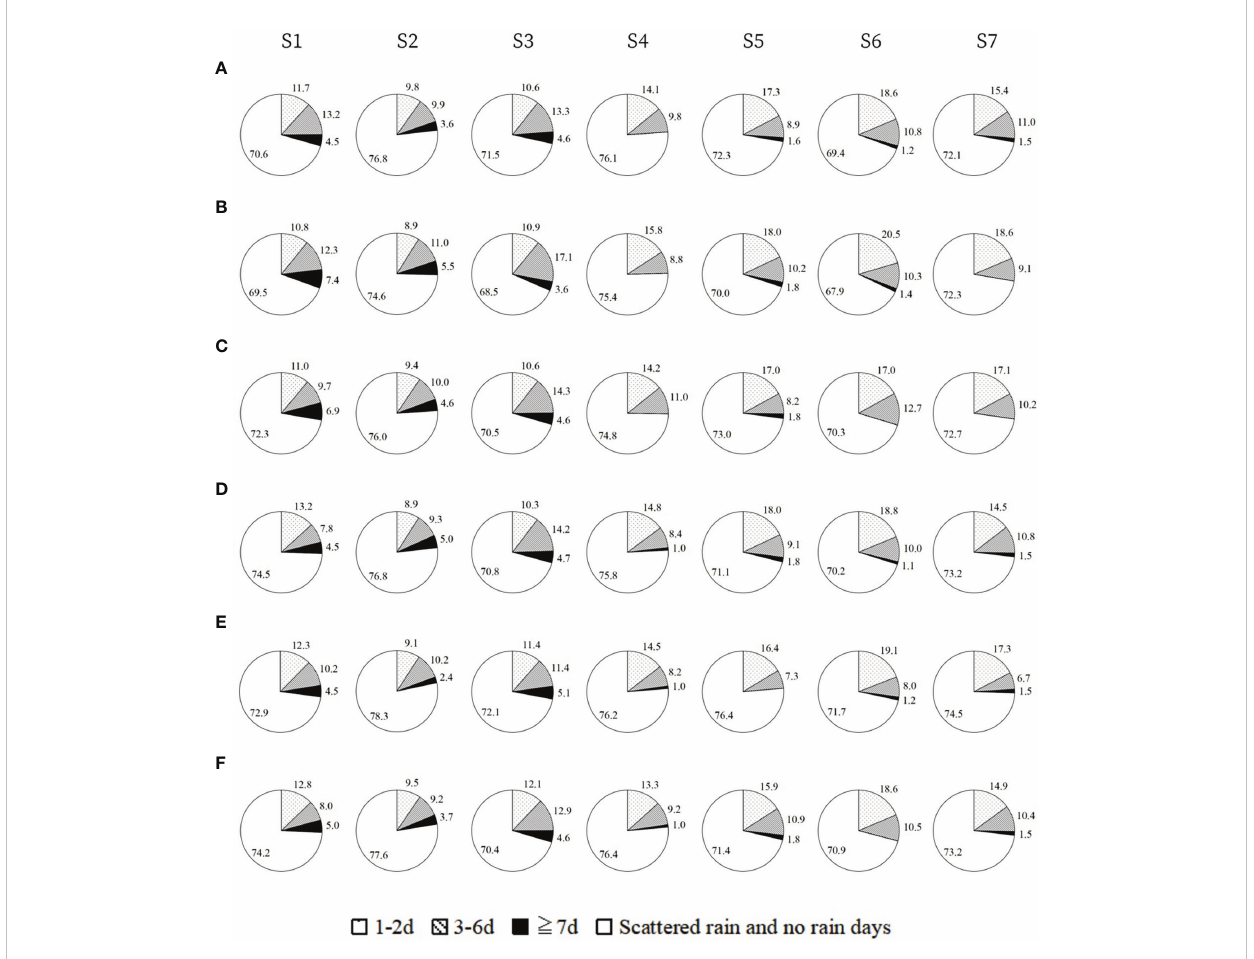
FIGURE 6 Frequencies of continuous rain during different winter wheat growth stages in Yanhuai region i.e. (A) Yingshang, (B) Huoqiu, (C) Fengtai, (D) Shouxian, (E) Huaiyuan, and (F) Fengyang from 1999 to